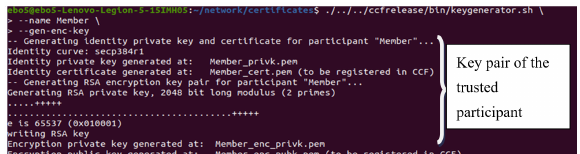
Fig. 1. Key generation of consortium participant.